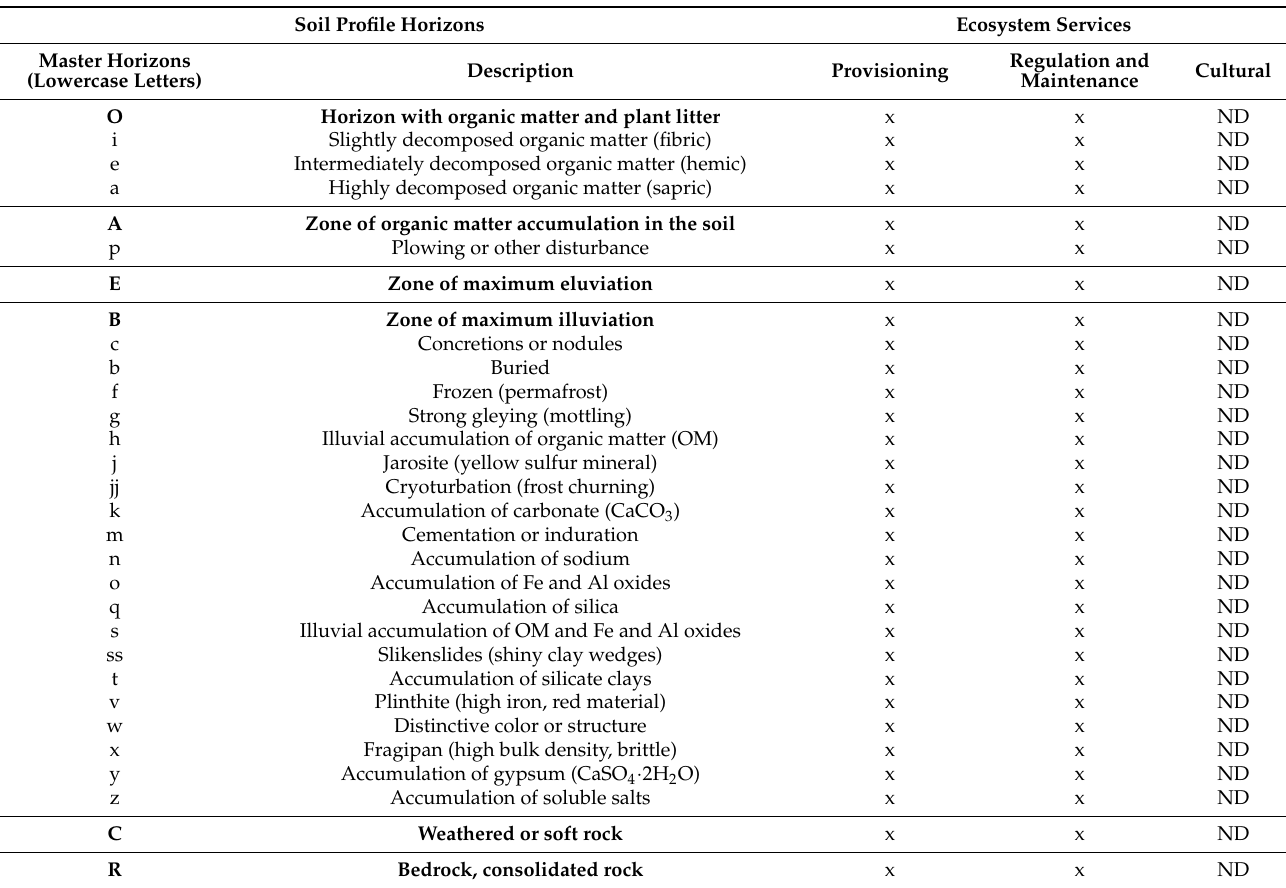
Figure 3. Examples of variations of soil horizons in different soil profiles. Table 12. Examples of soil profile horizons (master horizons and corresponding lowercase letters commonly used with these horizons) and ecosystem services (adapted from Hartemink et al. (2020) [40].